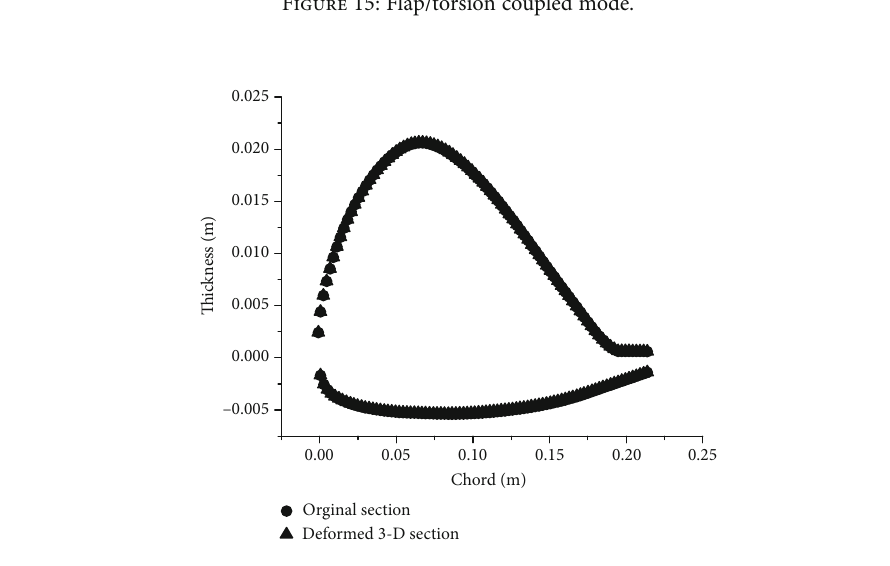
Figure 16: Deformed sections of 3-D model ( AR = 18 : 07 ).